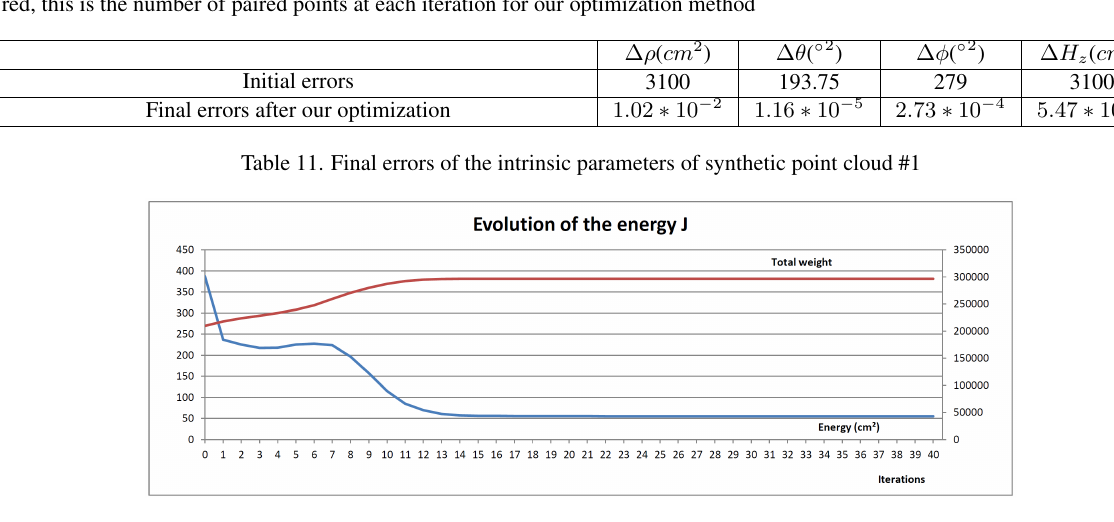
Figure 12. Evolution of the energy of the real point cloud #2. In blue, we show the evolution of our energy during the optimization; in red, this is the number of paired points at each iteration for our optimization method